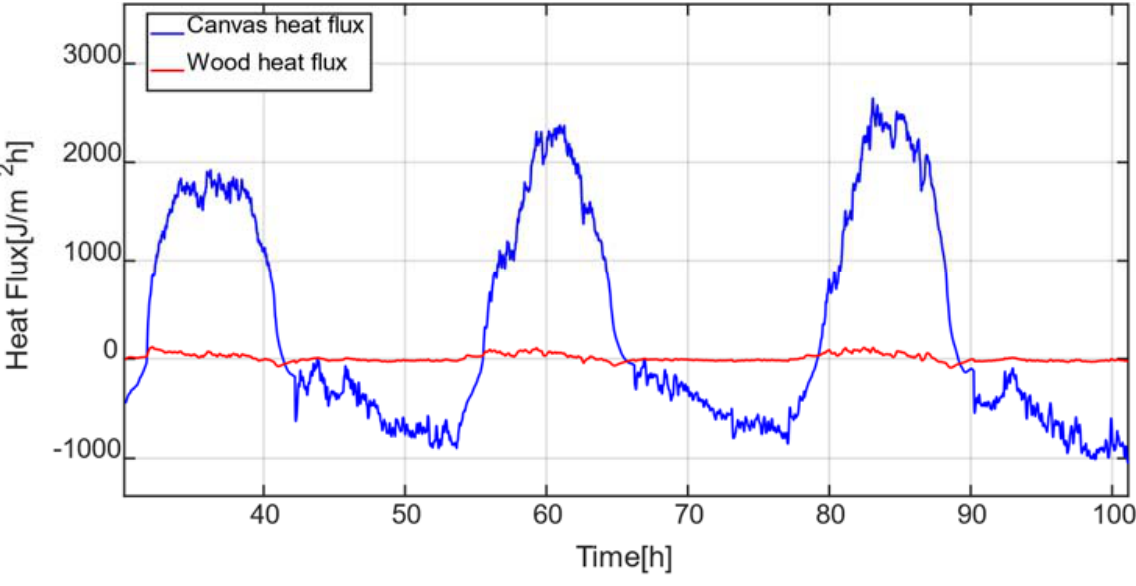
Figure 6. Incoming heat flux through canvas and the wooden structure versus time.